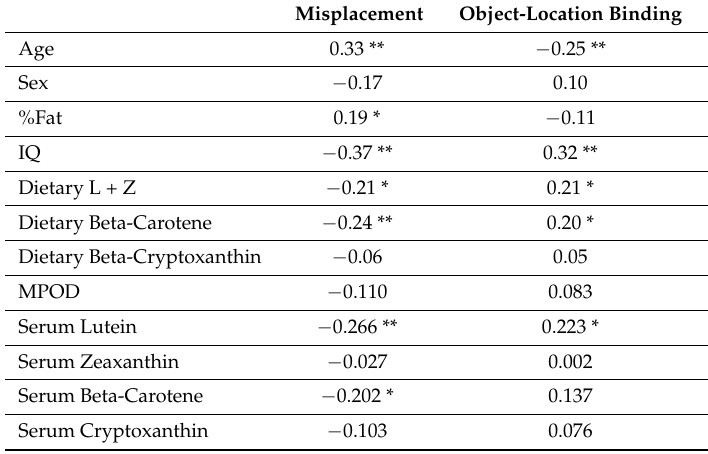
Table 2. Bivariate correlations (Pearson’s r ) between relational memory, participant characteristics, and